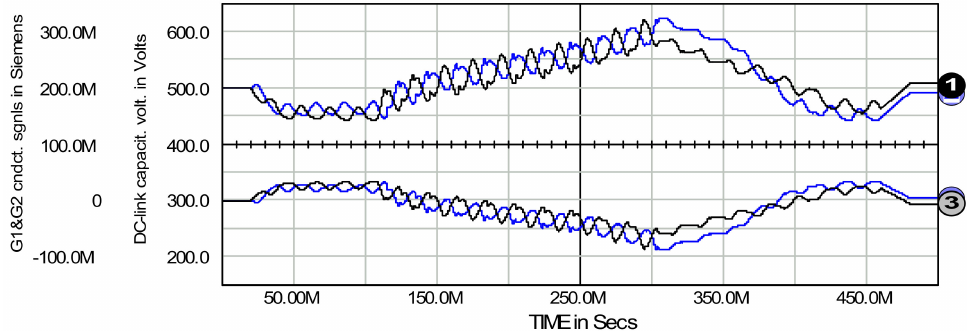
Figure 23. DC-link capacitor voltages: waveforms 1 and 2, and load conductance signals based on both DC-link capacitor voltages: waveforms 3 and